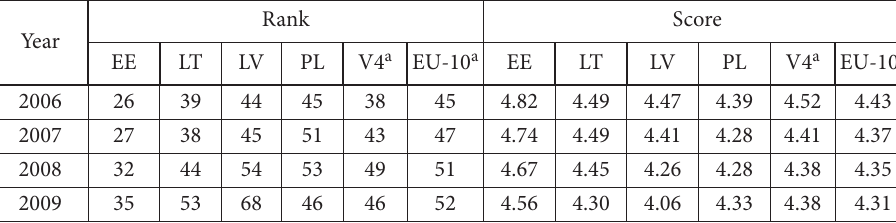
Table 4. Positions of the Baltic States against the backdrop of Poland, the V4 countries and the EU-10 in 2006–2017* in the competitiveness studies conducted by the WEF (source: Own calculations based on WEF, 2015,